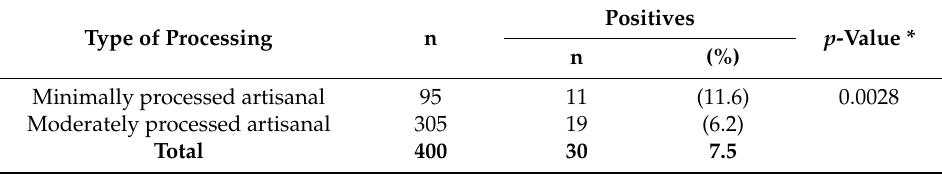
Table 2. Positivity of Listeria monocytogenes in minimally and moderately processed artisanal